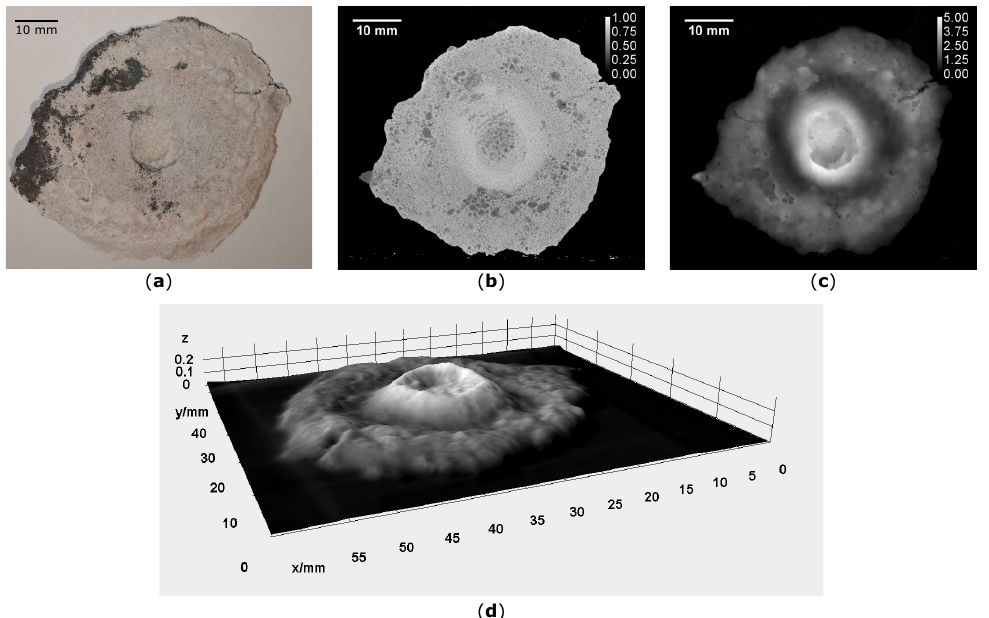
Figure 8. Images of a raft from alumina bulk type B. ( a ) Image of raft from above. ( b ) Projected CT image of the raft seen from above, displaying the average density. ( c ) Projected CT image of the raft seen from above, displaying the thickness of the raft.The scale is given in mm. ( d ) 3D-image plot seen from the side.